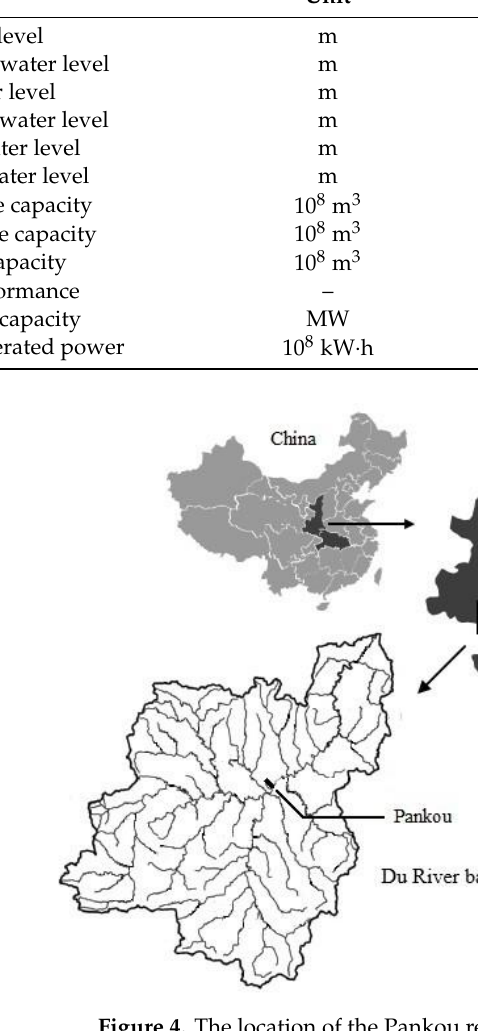
Figure 4. The location of the Pankou reservoir.